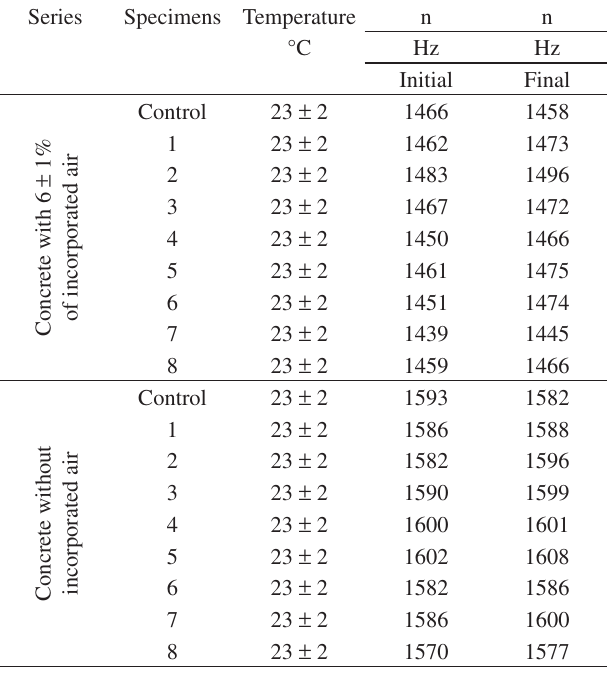
Table 6. Natural transversal frequency of prismatic specimens 10 x 10 x 50 cm after 35 days of exposure to low temperatures. Series